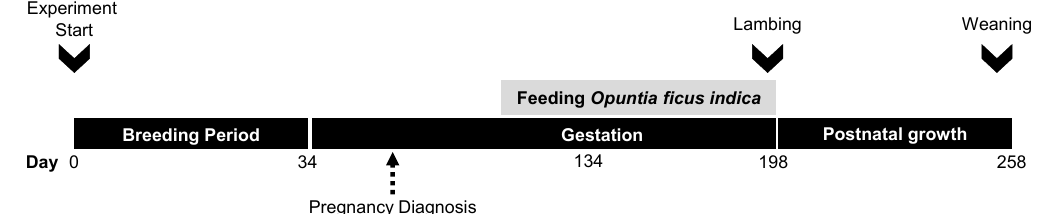
Figure 1. Schematic representation of the experimental design. Day 0 represents the day when the males were introduced and the breeding period started. Dietary treatments began around day 100 of gestation and continued until lambing.